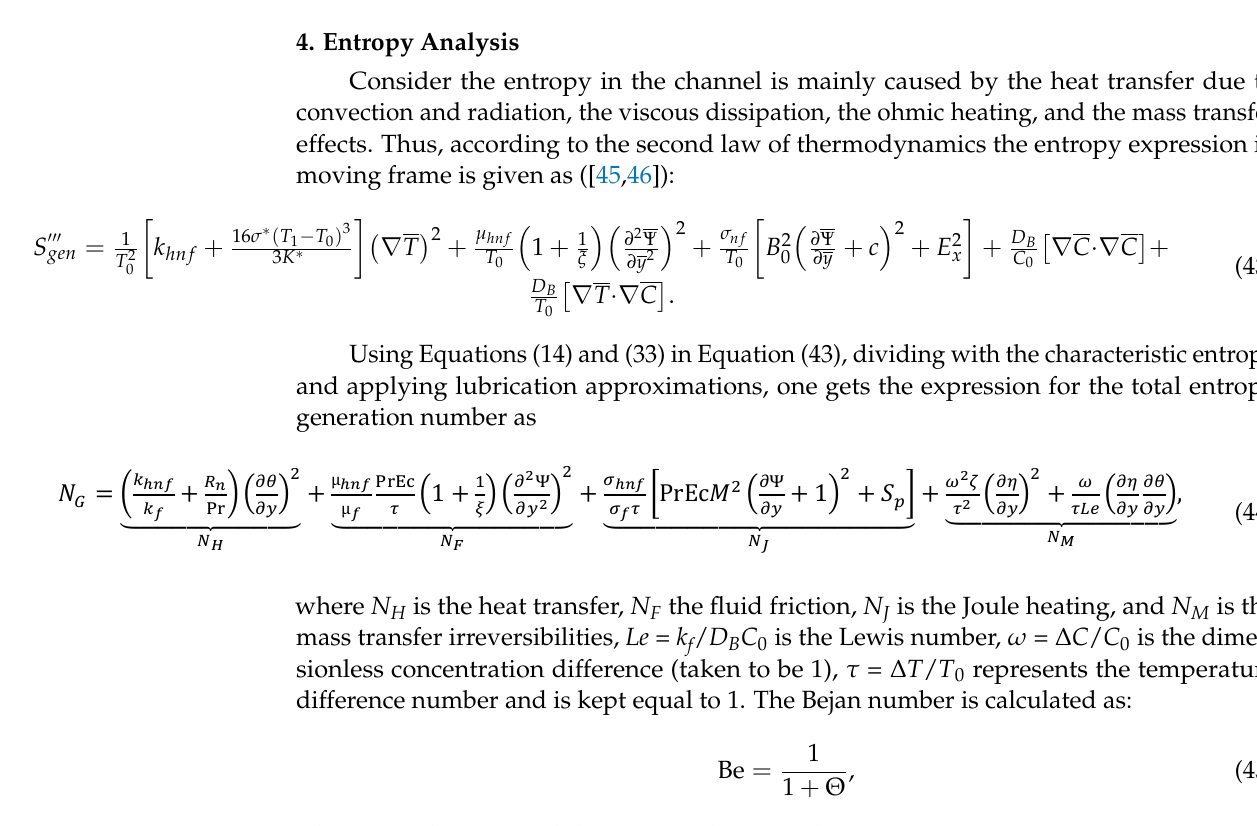
( d ) Figure 3. The axial velocity distribution u ( y ) versus y for varying ( a ) magnetic field M ( b ) Helmholtz-Smoluchowski ve- locity U hs , ( c ) Grashof number g r , and ( d ) solutal Grashof number g c